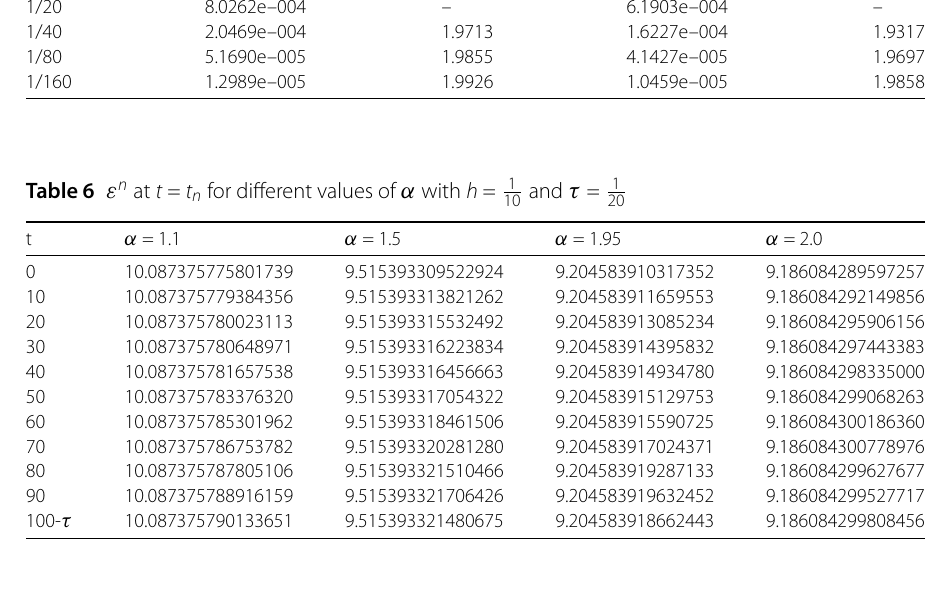
Table 5 The convergence order in temporal direction with α = 1.5,1.95, h = 1/300 at time t = 1